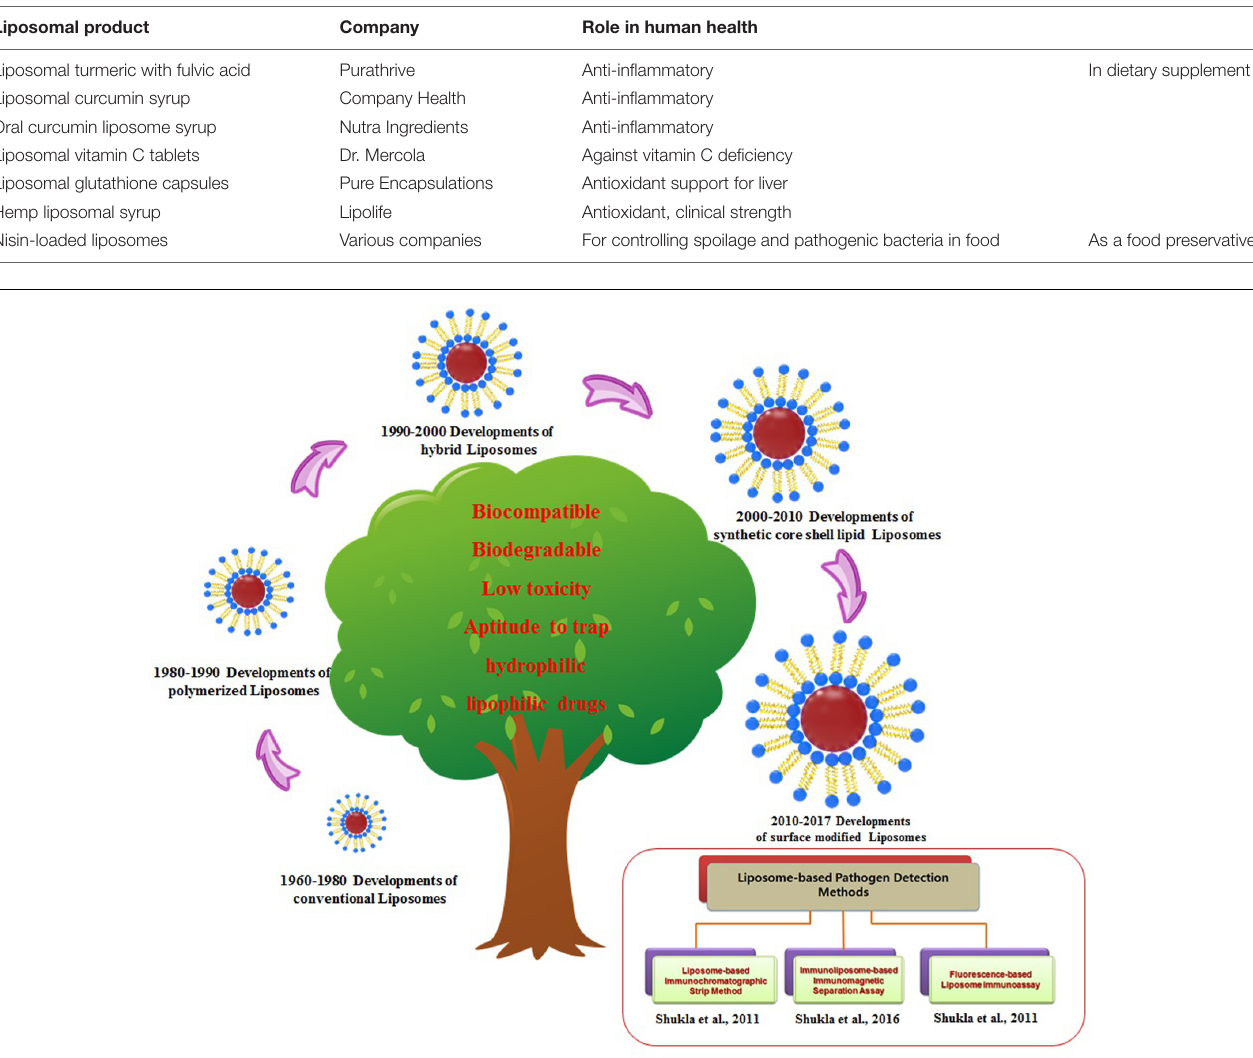
FIGURE 3 | History and evolution of liposomes nanoparticles with applied strategies for the liposome-based detection